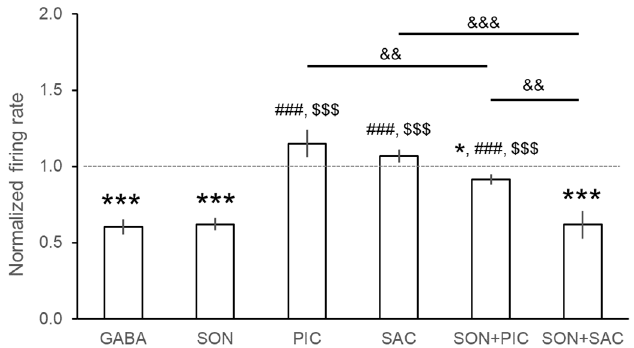
Figure 1. Frequency histograms of representative neurons from the rat forebrain. Microiontopho- retic injection of songorine (SON) inhibited neuronal activity ( A ). After the termination of the ejec- tion of SON, the spontaneous neuronal activity always returned. Picrotoxin (PIC) successfully blocked the inhibitory effects of SON ( B ). However, the application of saclofen (SAC) did not mod- ulate the inhibitory effects of SON ( C ).